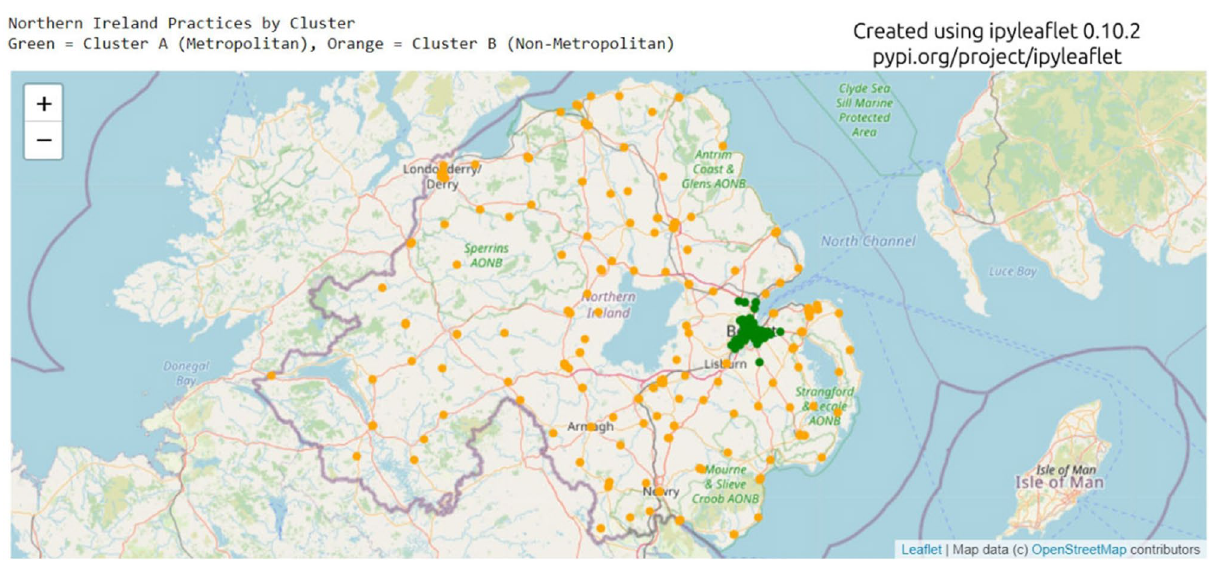
Figure 4. Map of GP practices by Cluster in Northern Ireland (grey line denotes the border of Northern